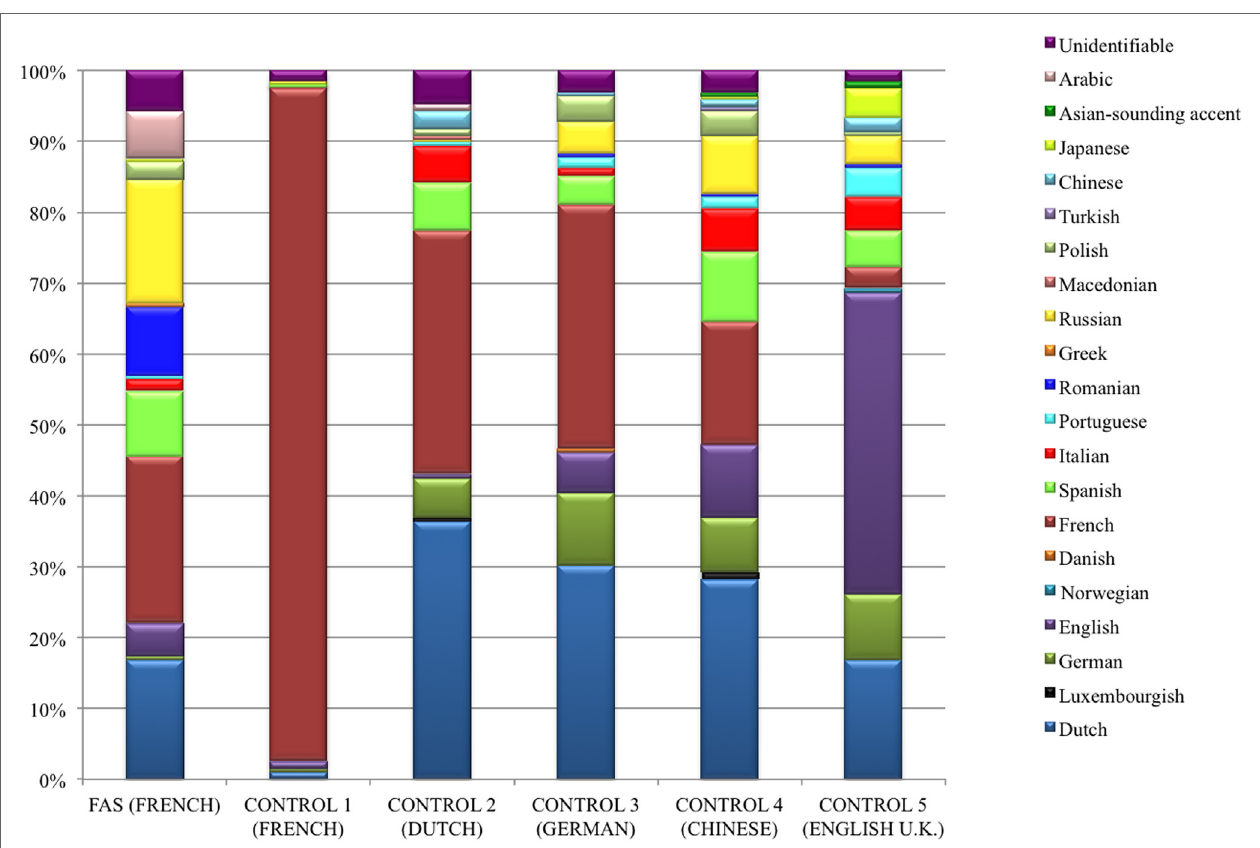
FIGURe 2 | Graphic representation of the stratification of the different native languages which 13 native French-speaking raters associated with the stimuli for the Fas patient and each of the control speakers . The FAS speaker was associated with 14 different accents including French. However, comparison of the FAS patient with the native French-speaking control clearly demonstrates that the raters identified the control’s accent as their own in 95% of the stimuli versus a mere 24% for the FAS patient (see Accent Attribution